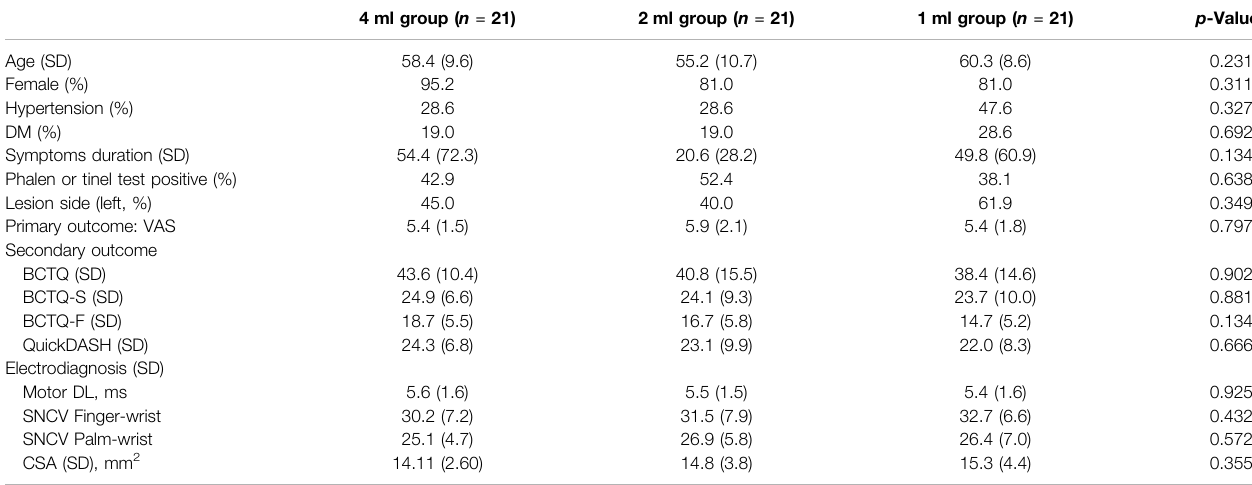
TABLE 1 | Baseline characteristics between three groups.